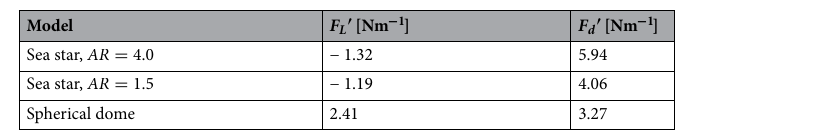
Table 1. Mean values for lift ( F L ′ ) and drag ( F d ′ ) per unit length estimated from control volume analyses of planar vector fields obtained from PIV.